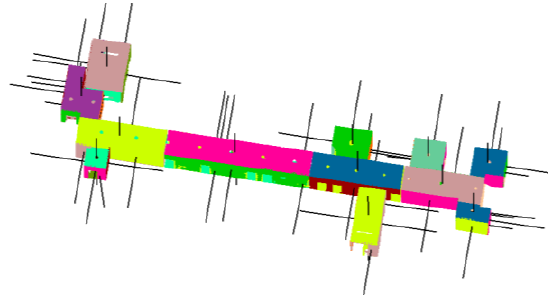
Figure 6. Detected reference planes and their normal vectors which point outward of the building.